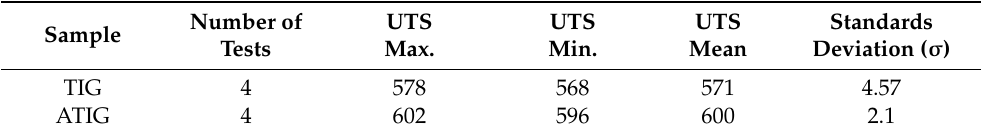
Table 8. Results of UTS (MPa) and standard deviation of TIG and ATIG.